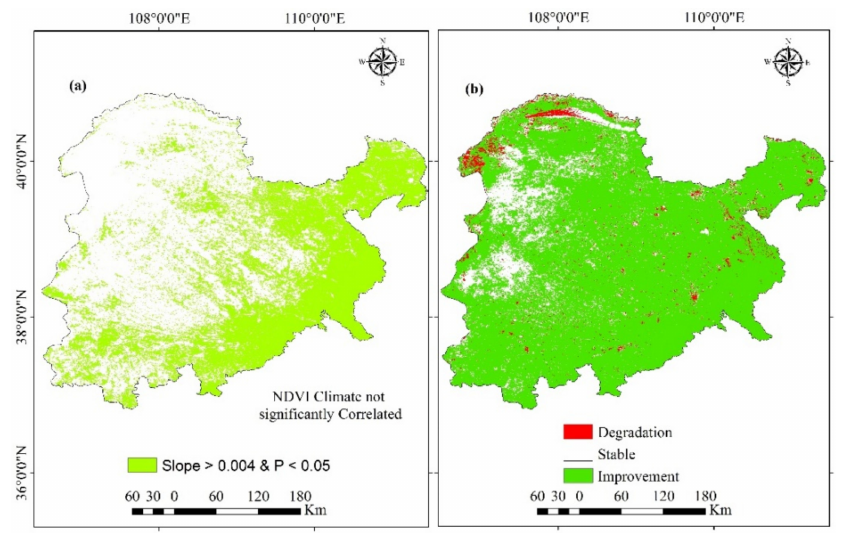
Figure 6. ( a ) Significant Restoration in MU-SU caused by Ecological restoration Programs (2001–2018) ( b ) Land degradation in Mu Us based on SDG Indicator